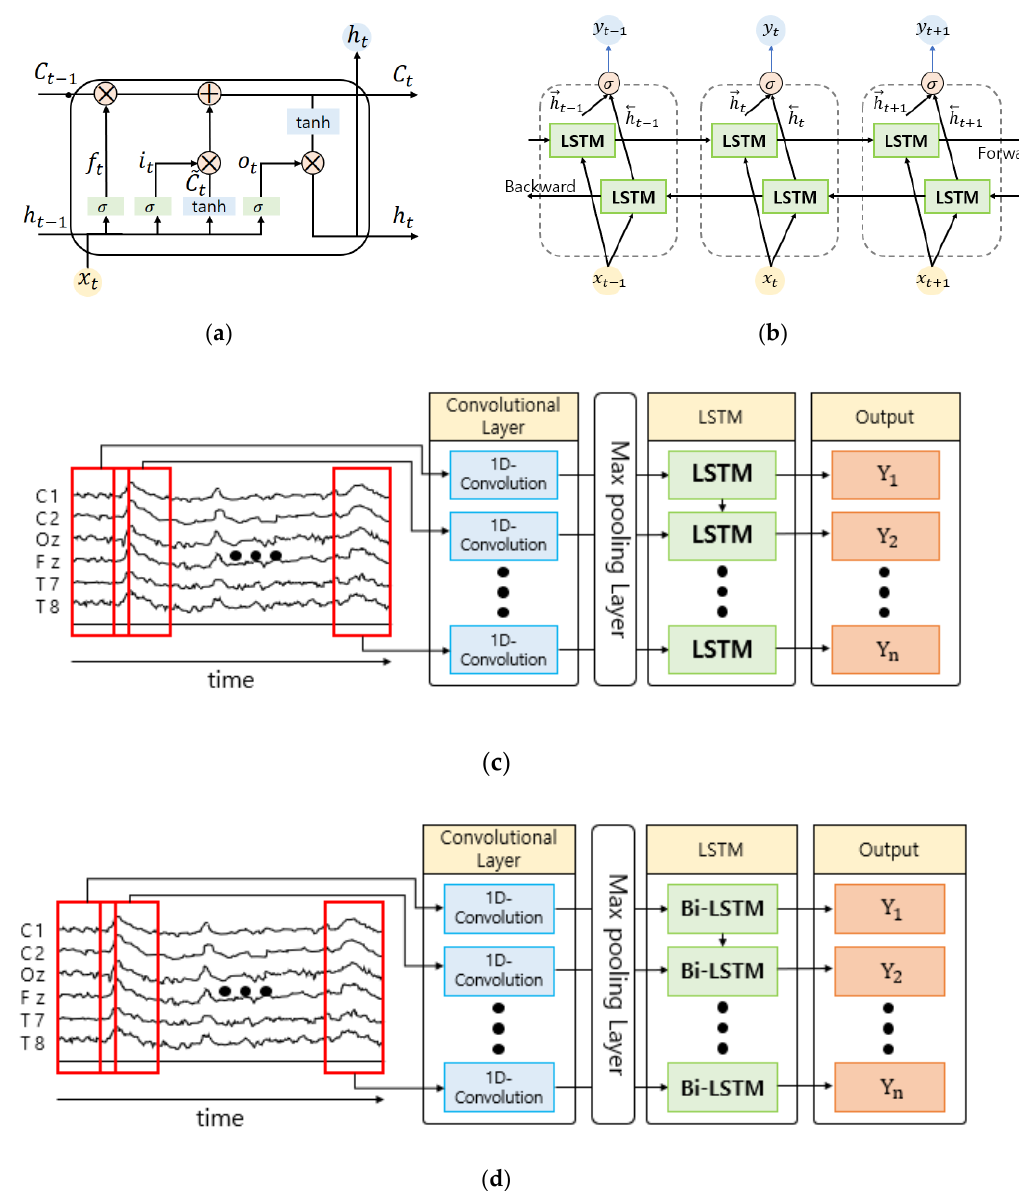
Figure 5. The architecture of the four deep learning models used in the experiment: ( a ) LSTM; ( b ) Bidirectional LSTM; ( c ) CNN–LSTM; ( d ) CNN-Bidirectional LSTM.